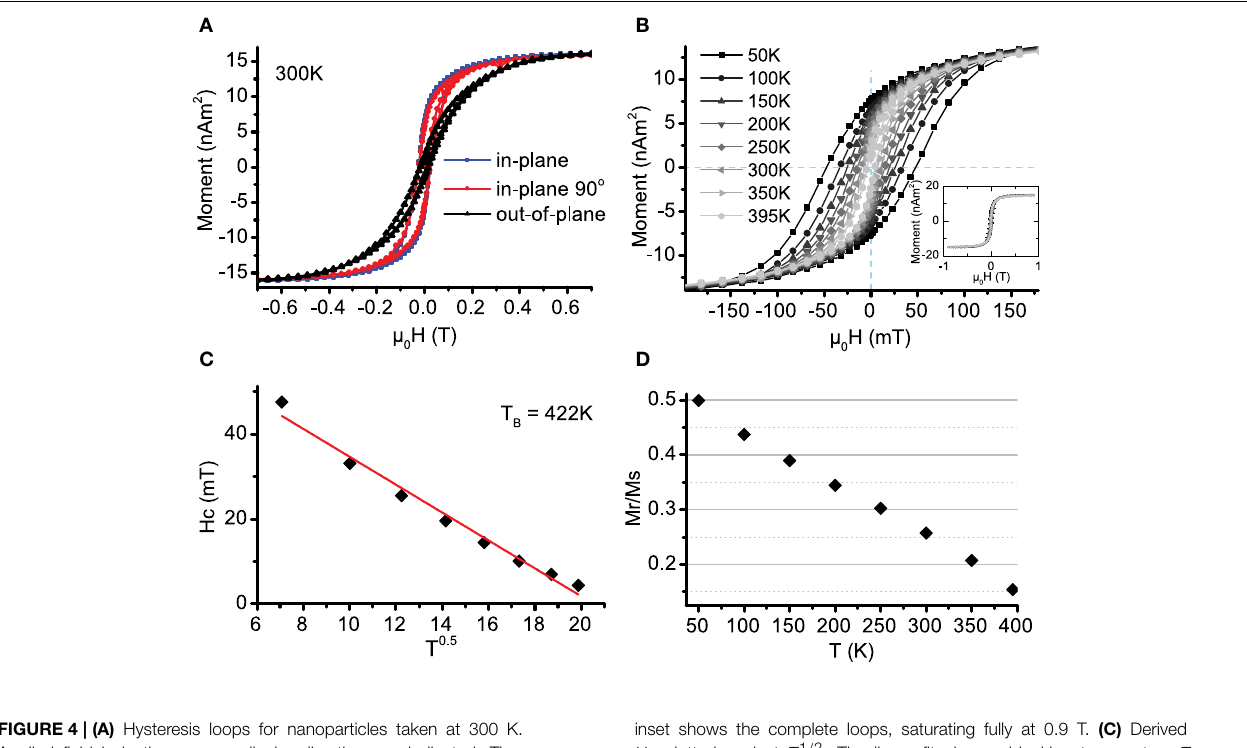
inset shows the complete loops, saturating fully at 0.9 T. (C) Derived H c plotted against T 1 / 2 . The linear fit gives a blocking temperature T B of 420 K. (D) M r / M s plotted against temperature. This predicts a blocking temperature of 450